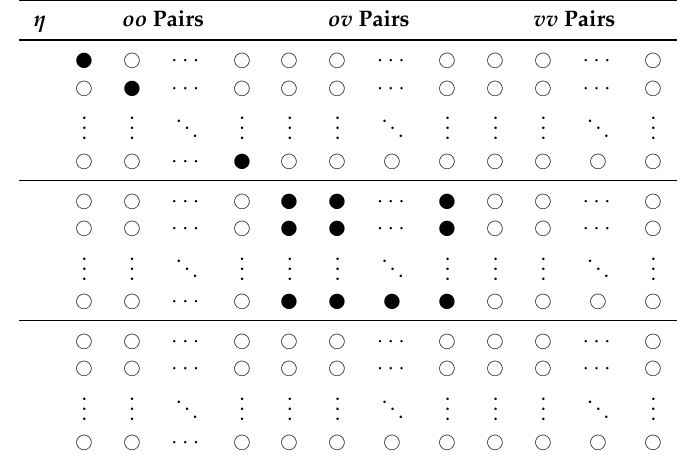
Table 1. Structure of the η matrix in a IQA/MP2 calculation. Empty ( zero and non-zero values,